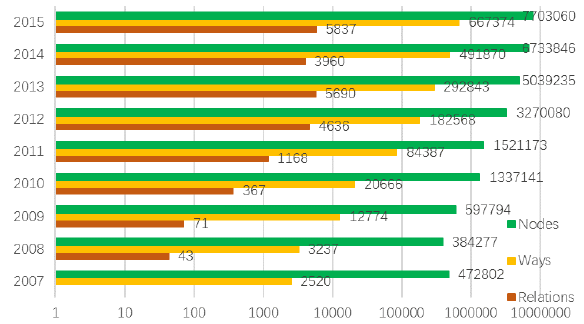
Figure 5. Number of Nodes, Ways and Relations in